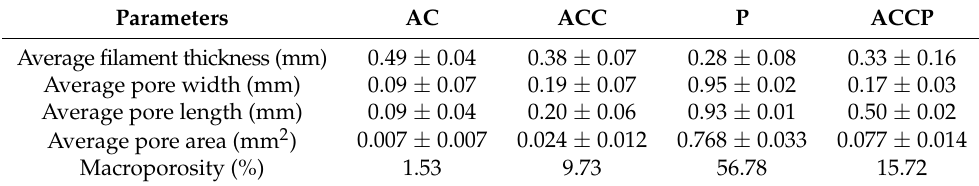
Figure 1. Macropores of 3D printed scaffolds visualized under 2 × and 4 × magnification. Table 1. Measured filament thickness, pore dimensions, and calculated macroporosity of the 3D printed